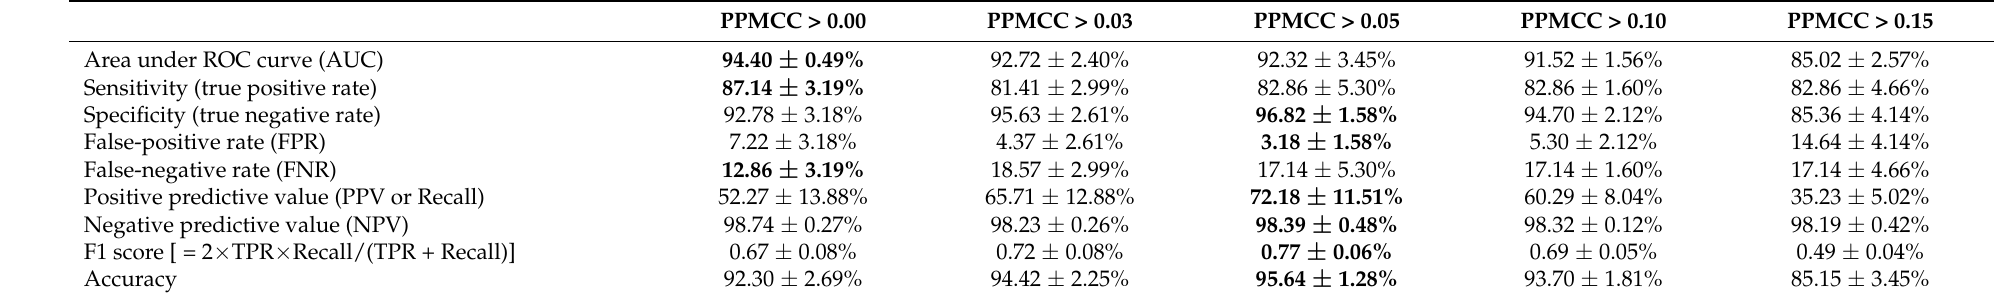
Table 2. Effectiveness evaluation indexes of the scoring function.